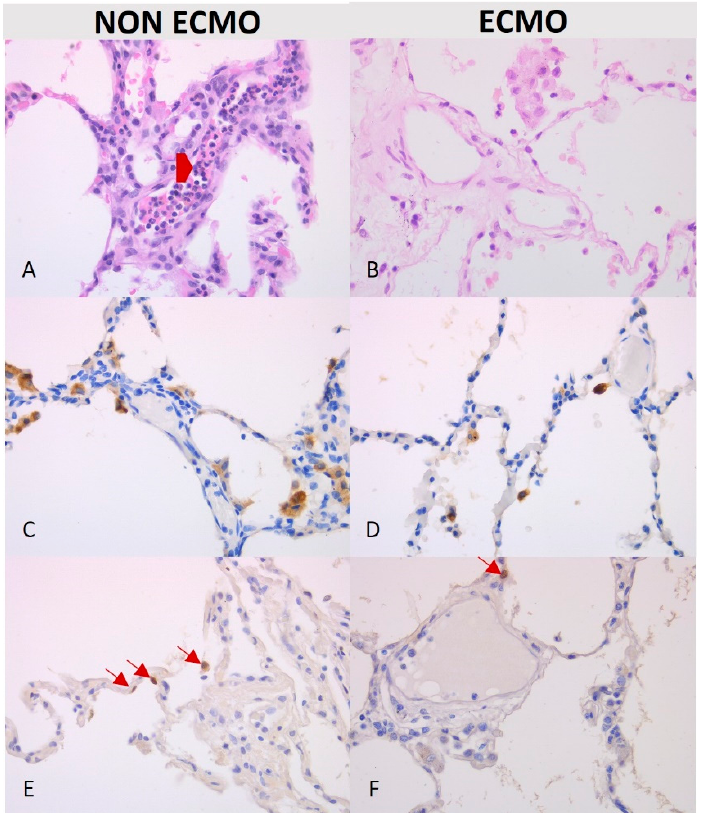
Figure 5. Explanatory figures for the ECMO and non-ECMO patients. Leukocyte margination (( A , B ) hematoxylin and eosin staining, 40× original magnification, red arrowhead), iNOS expression (( C , D ) immunohistochemistry, 40× original magnification), and apoptotic cells (dark nuclei, red arrows) ( E , F tunel assay, 40× original magnification) are more evident in non-ECMO than in ECMO patients.